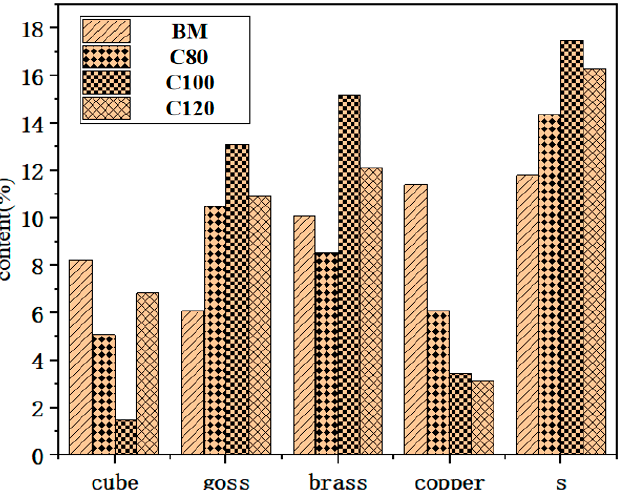
Figure 6. Austenite Texture Content of the Original Inconel 625 Sample and Specimens Treated with EBSA at Different Scanning Speeds.